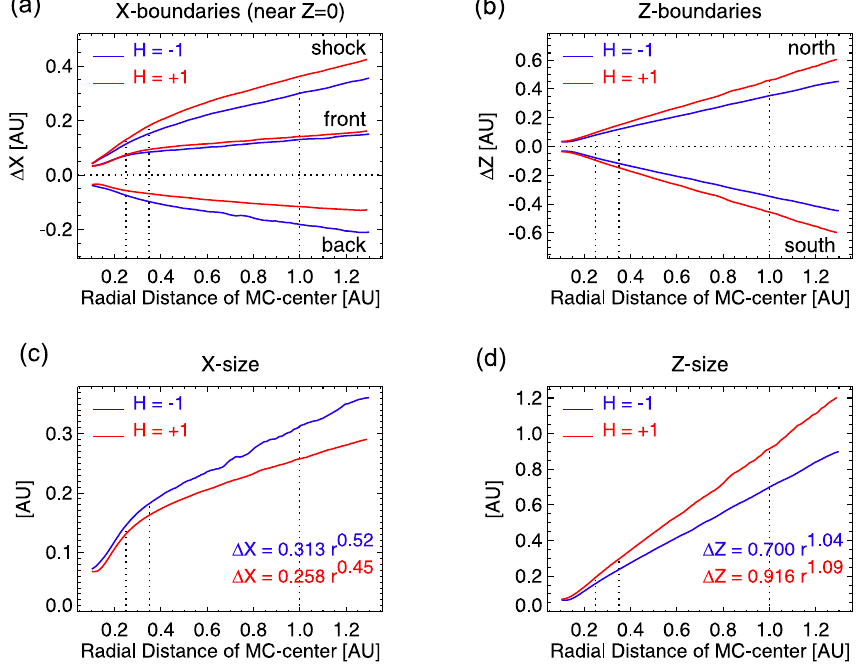
Fig. 15. Evolution of the MC-boundaries and shock fronts for H − m (in blue) and H + m (in red) (a, b) . Boundary and shock positions are taken along the x-direction at z = Z MC − center . The MCs’ sizes into x-direction (c) and into z-direction (d) are displayed in the lower row. Radial fits inside the range 0 . 3 − 1 . 0AU are listed as